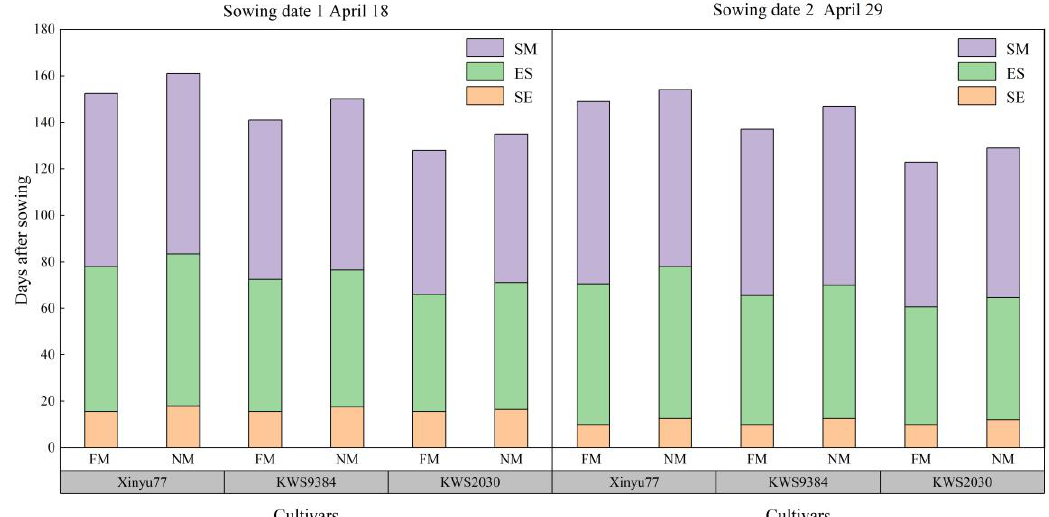
Figure 2. Maize growth periods using film mulch (FM) and no film (NM) planting with two sowing dates in 2021 and in 2022. SE, from sowing to emergence, ES, from emergence to silking, SM, from silking to physiological maturity. Data are means, n = 5.